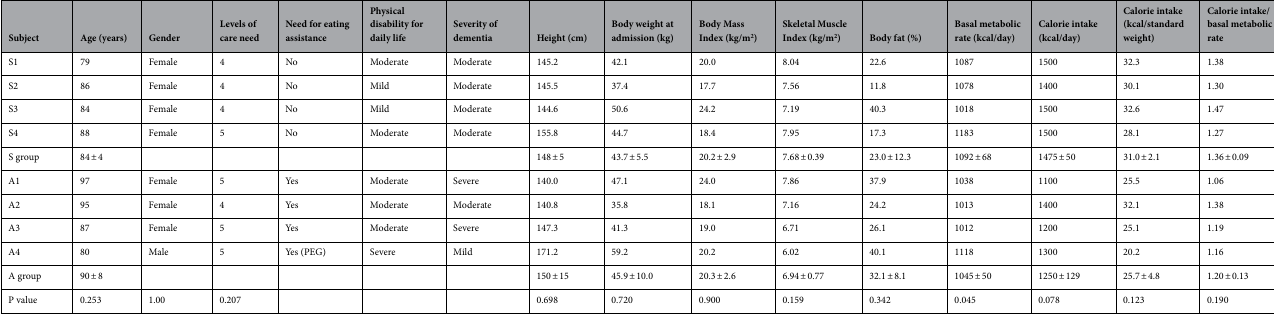
Table 1. Participants’ background variables and results of body composition